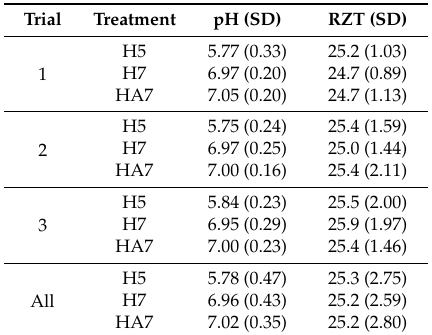
Table 3. Tub averages and standard deviation (SD) of pH and root zone temperature (RZT, ◦ C) by trial and